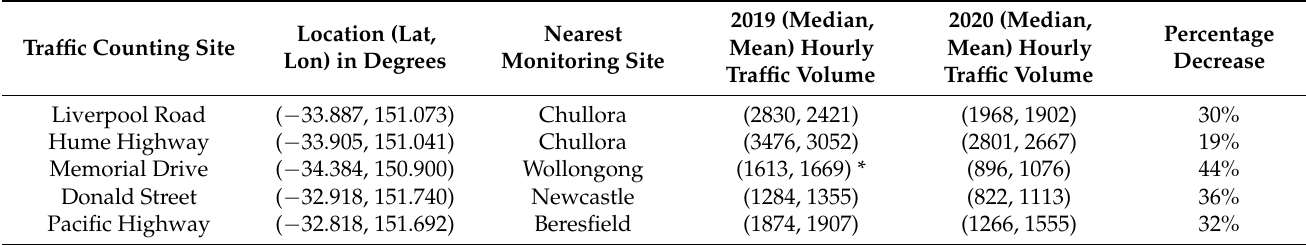
Table 2. Traffic counting site and comparison of 2019 and 2020 median hourly traffic